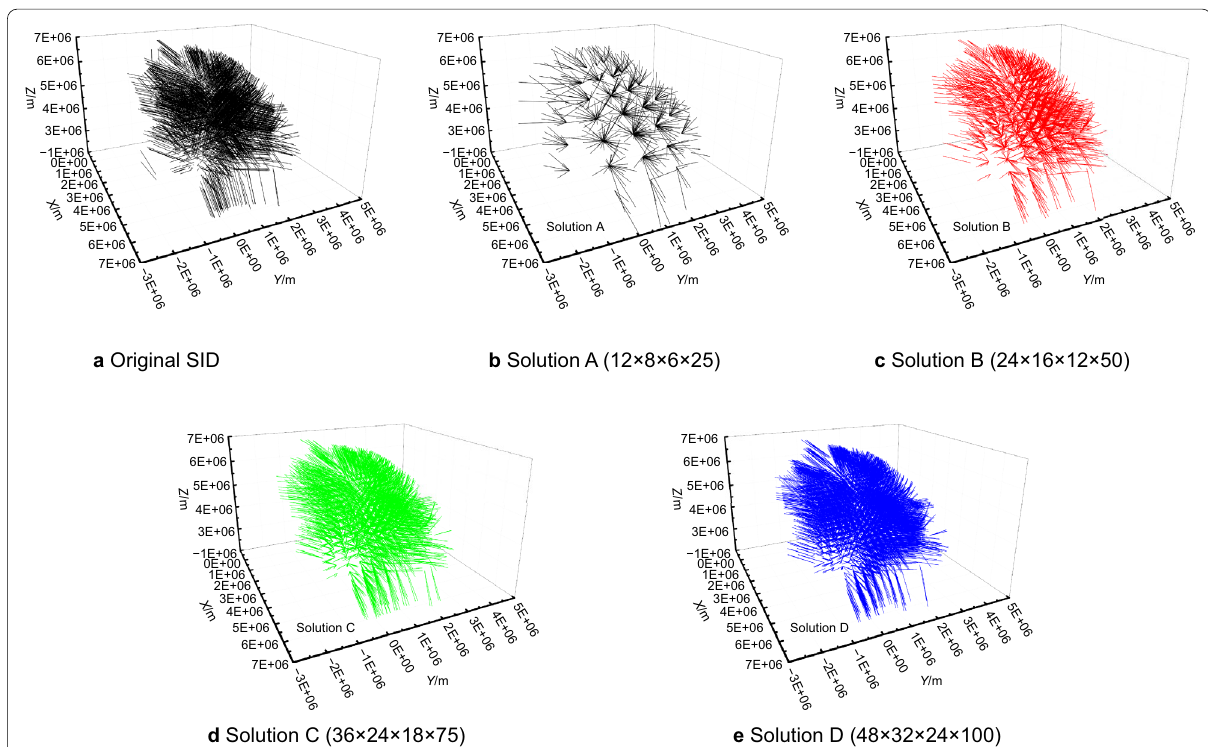
Fig. 2 The LOS map for the original SID, and each cluster, i.e., o i in Eq. (4) for solution A (12 (36 24 18 75), and solution D (48 × × ×